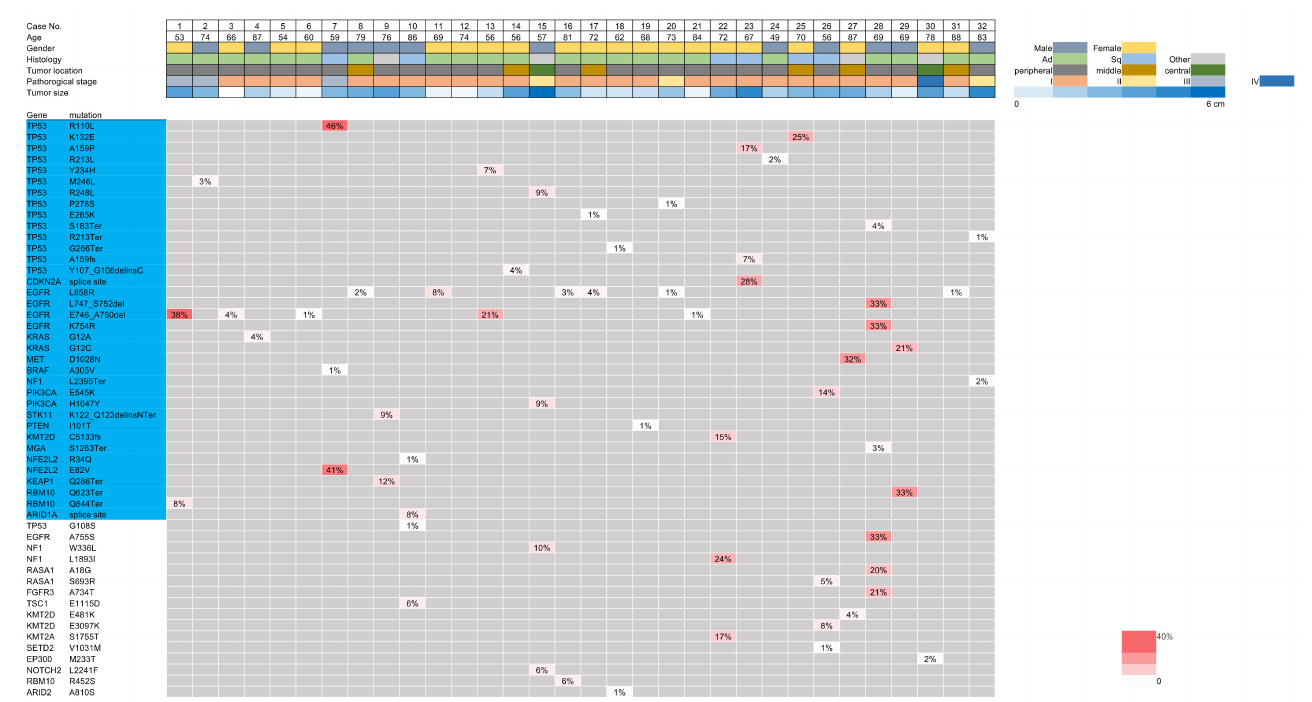
Figure 3. Shared mutations in the ex vivo bronchoalveolar lavage (BAL) fluid and lung cancer tissues. The shared mutations are shown with the allele fractions visualized on the heatmap. The gene mutations highlighted in light blue are oncogenic.